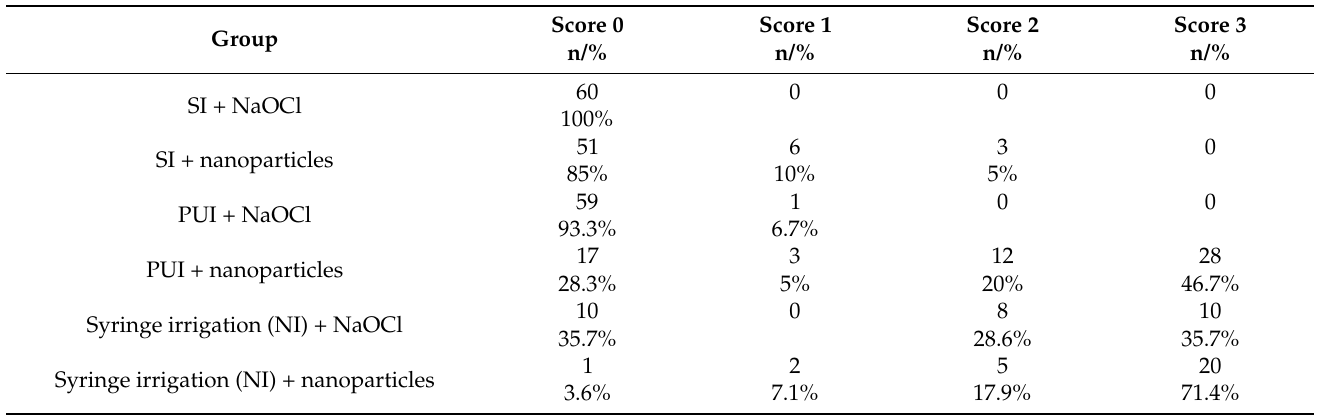
Table 1. Absolute and relative frequencies of added scores for holes and grooves (max. 60, for syringe irrigation max. 28).